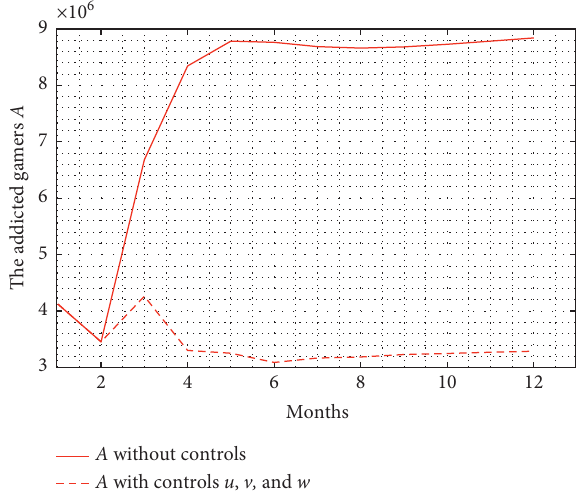
Figure 8: The evolution of the number of the addicted gamers with combination of the three controls.